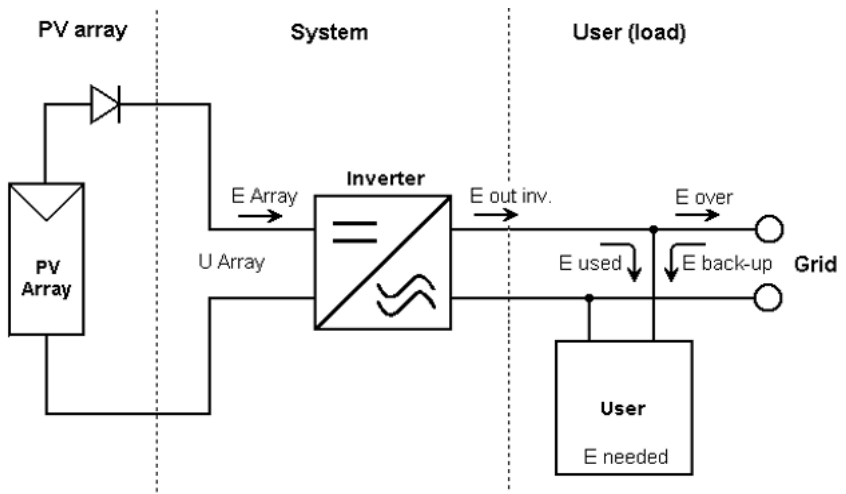
Figure 3. The operation principle of a grid-connected solar power system.